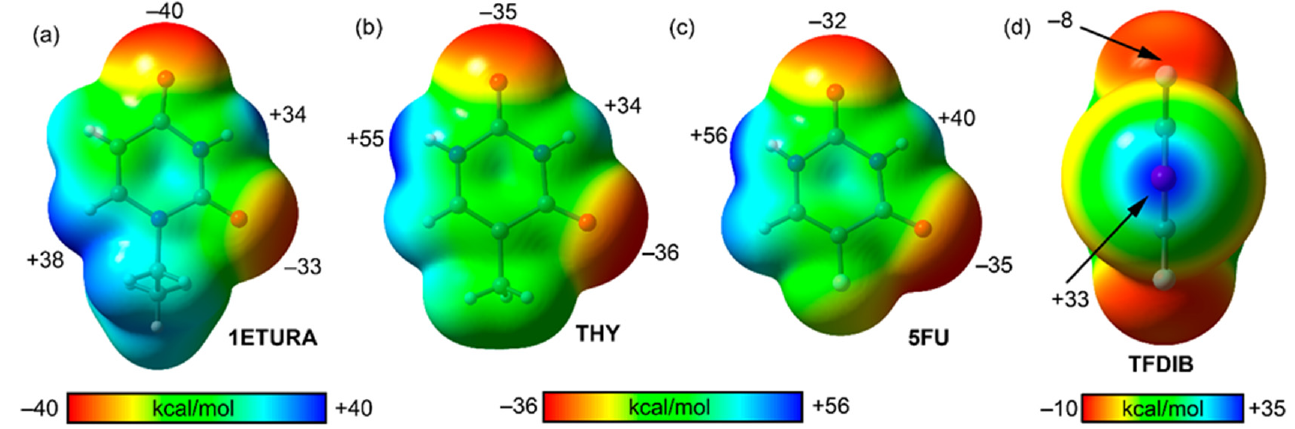
Figure 5. MEP surfaces of 1ETURA ( a ), THY ( b ), 5FU ( c ), and TFDIB ( d ) at the PBE0-D3/def2-TZVP level of theory. Isosurface 0.001 a.u. The values at selected points of the surface are given in kcal/mol.